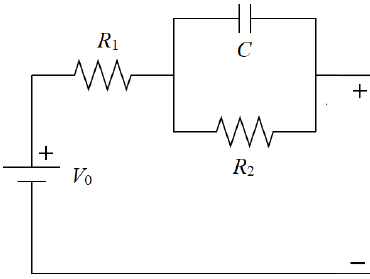
Figure A1. Thevenin equivalent circuit for modelling Li-ion battery chemistry.